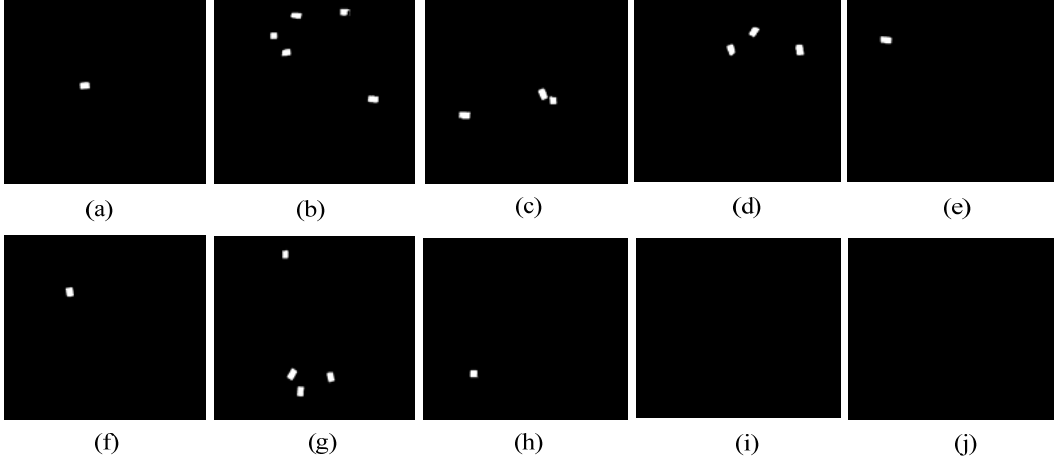
Figure 24. The results of the die regions in the abnormal cases corresponding to the images shown in Figure